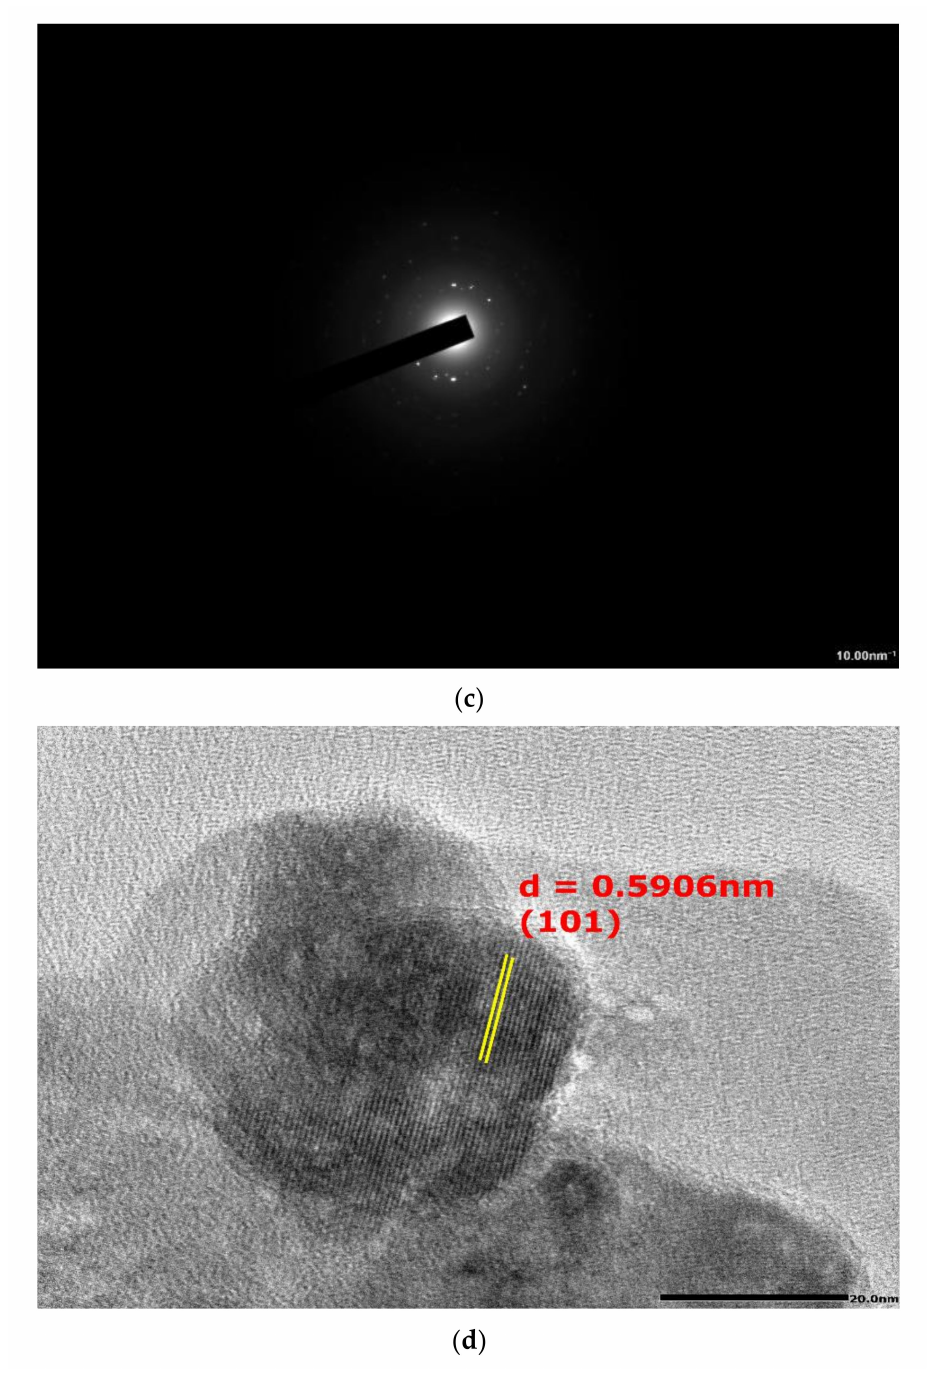
Figure 6. TEM micrograph ( a ), particle size distribution ( b ), SAED pattern ( c ) and d—spacing (given at 20 nm) ( d ) of